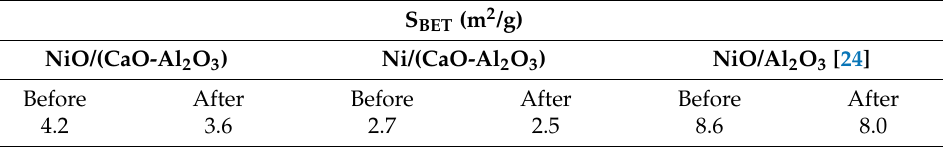
Table 1. The specific surface area before and after the process